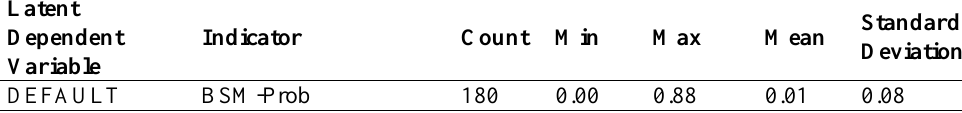
Table (10). Descriptive Statistics for Latent Dependent Variable